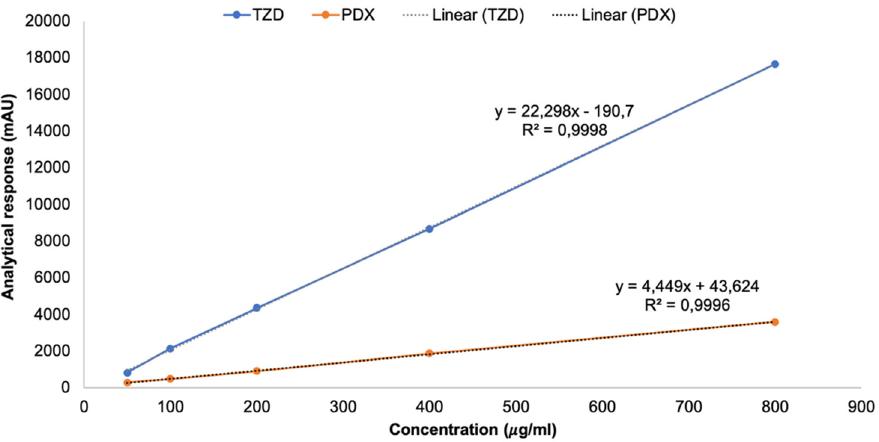
Figure 2. Regression plot obtained for TZD and PDX for a concentration range of 50.00–800 µ g/mL.